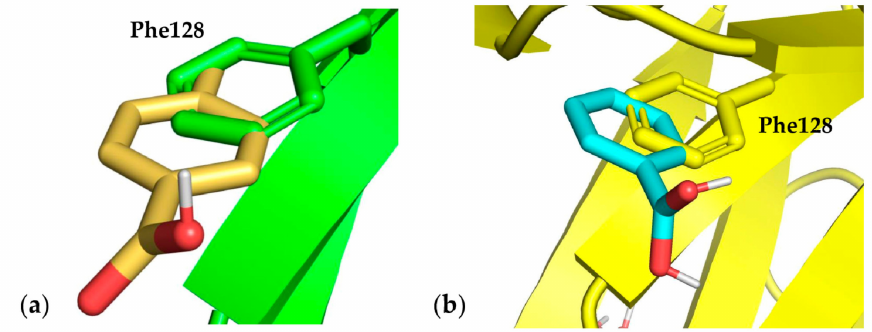
Figure 5. Best fragment poses for Phe mutation. ( a ) Docking pose number 2 for p -toluene boronic acid fragment probe in comparison with the native residue chain B Phe128, mutated to Gly; ( b ) Docking pose number 1 for phenylboronic acid fragment probe in comparison with the native residue chain B Phe128, mutated to